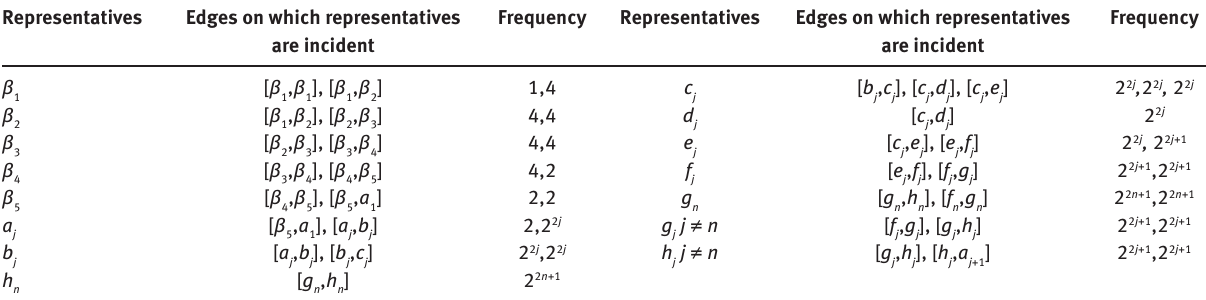
Table 5: Representatives with corresponding edges on which these are incident and their frequencies of occurrence for n ≥ 1.